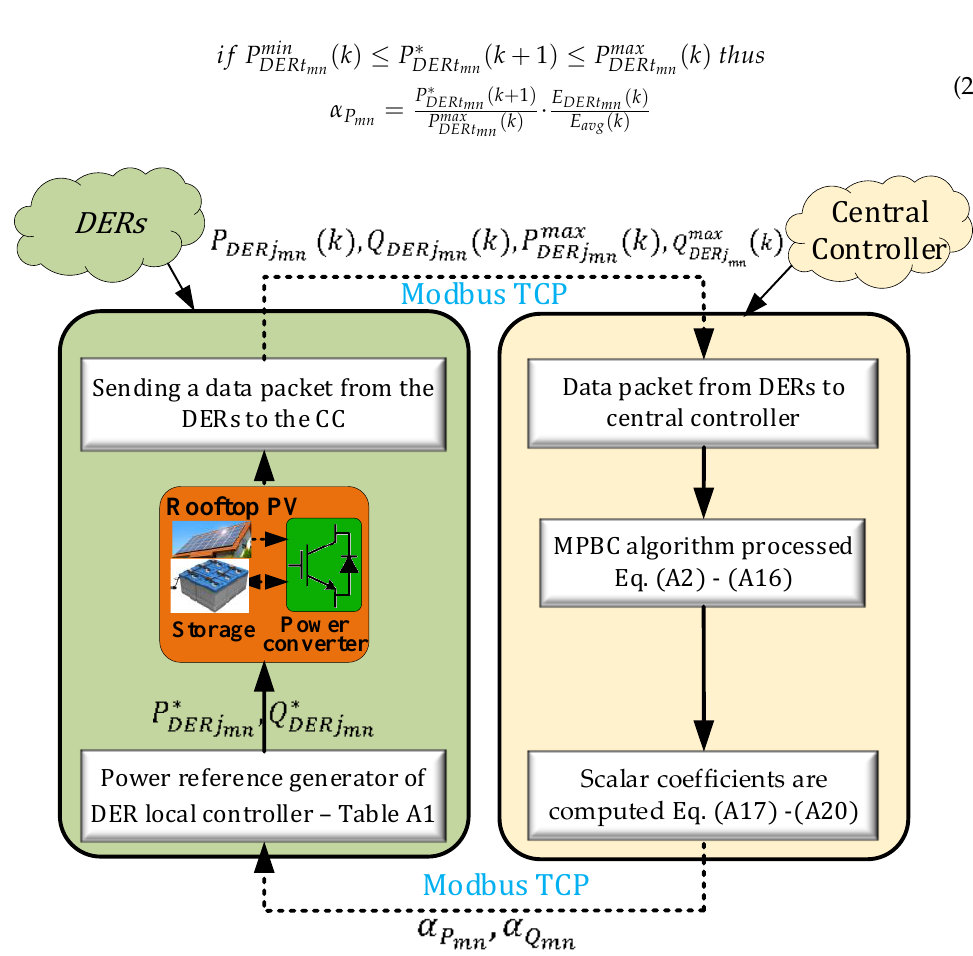
Figure 4. Flowchart of the proposed MPBC execution sequence.